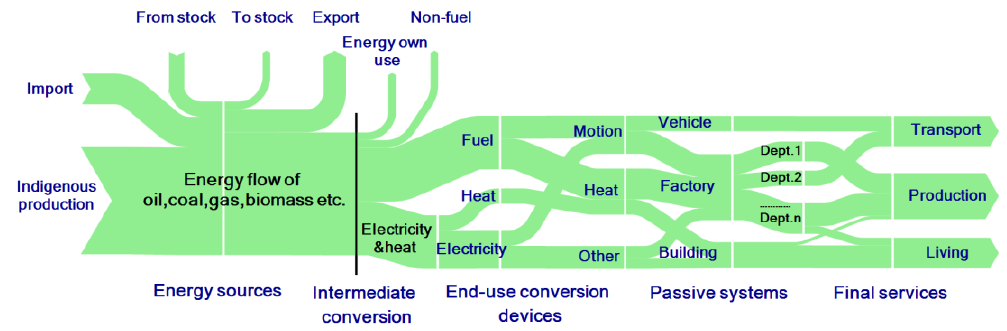
Figure 1. The framework of the energy flow Sankey diagram.